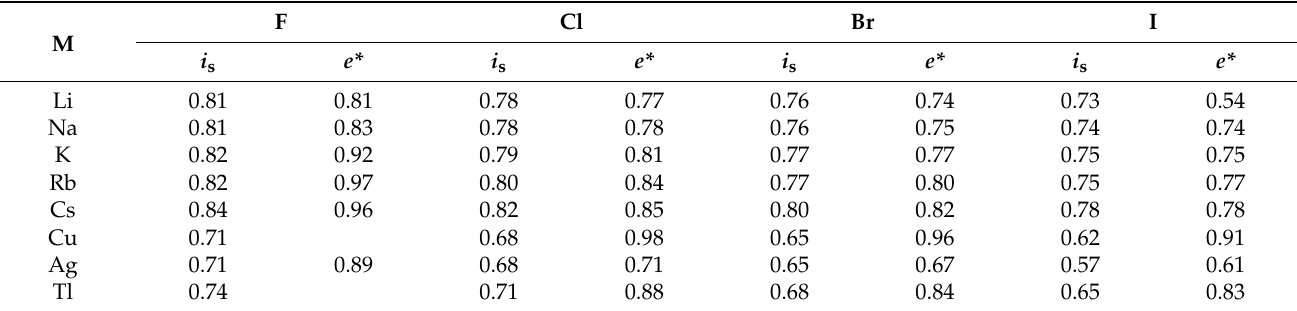
Table 10. Effective charges of atoms in MX